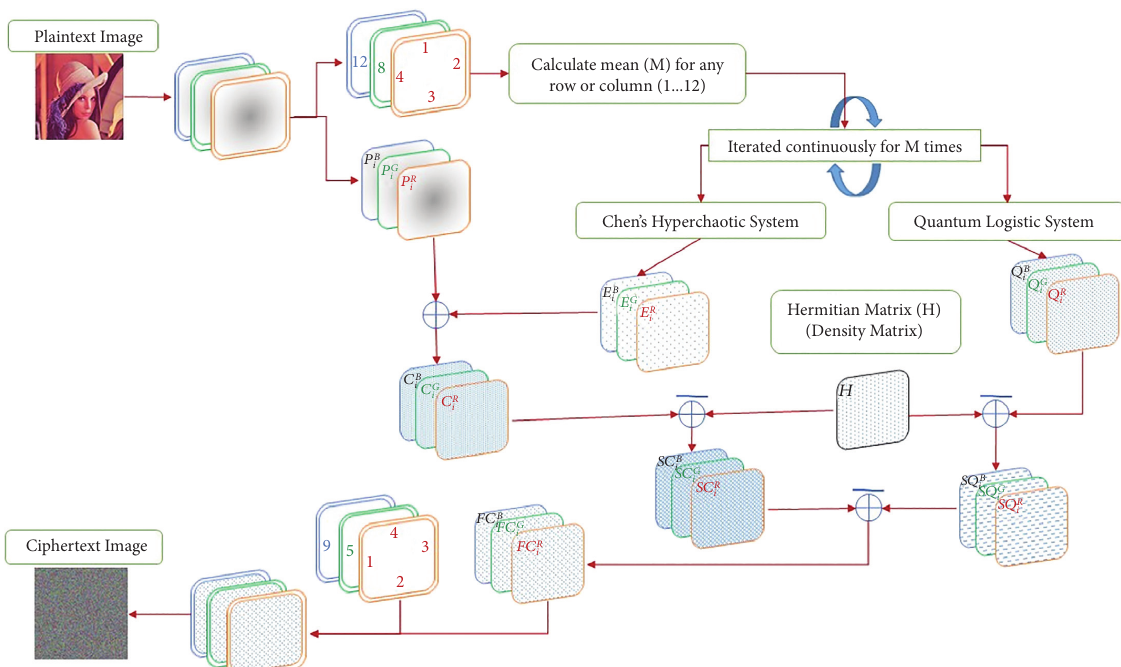
Figure 5: Block diagram of the proposed image encryption